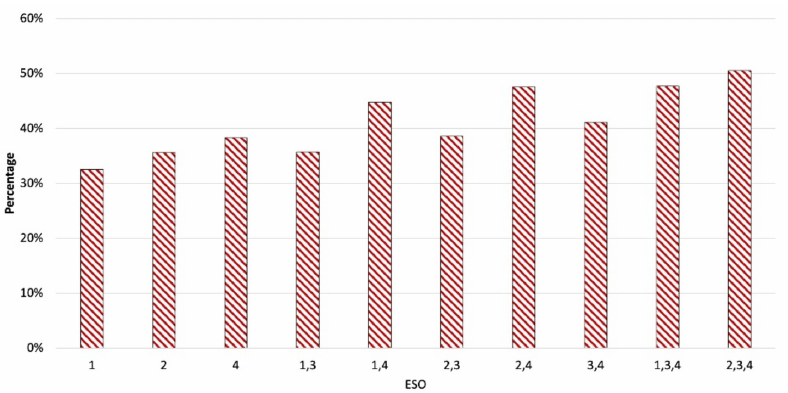
Figure 11. Total GHG emissions reduction in the residential building sector by government interven- tion through renewable energy.